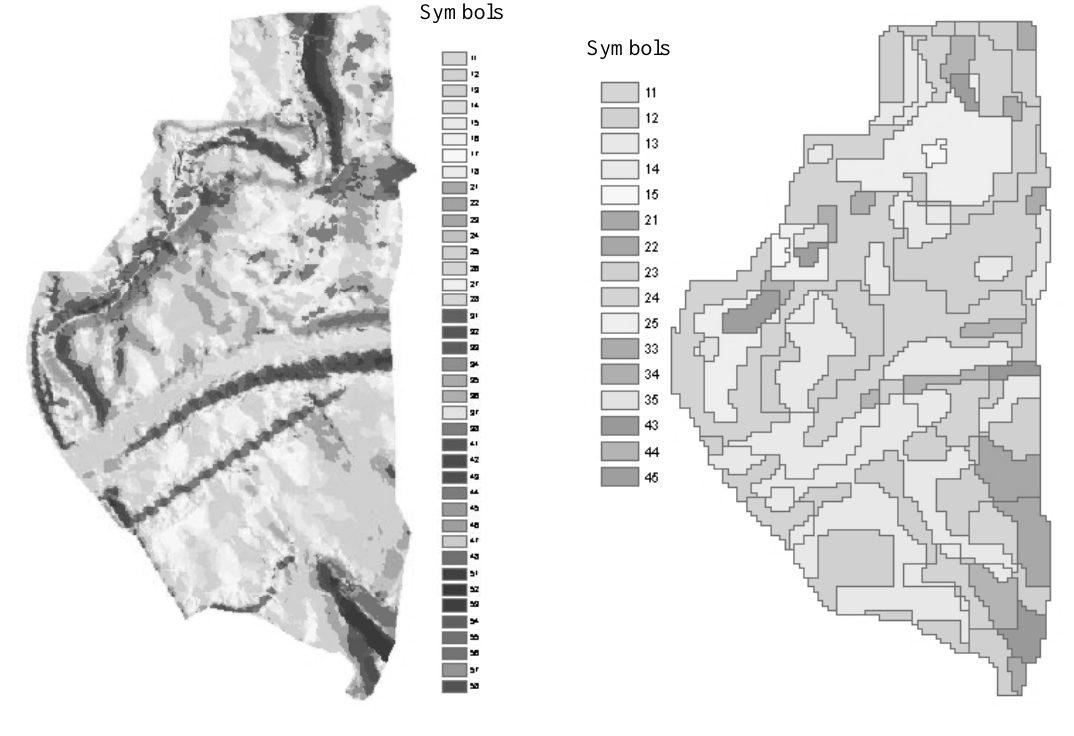
Fig 6. Slope aspect and value overlay map